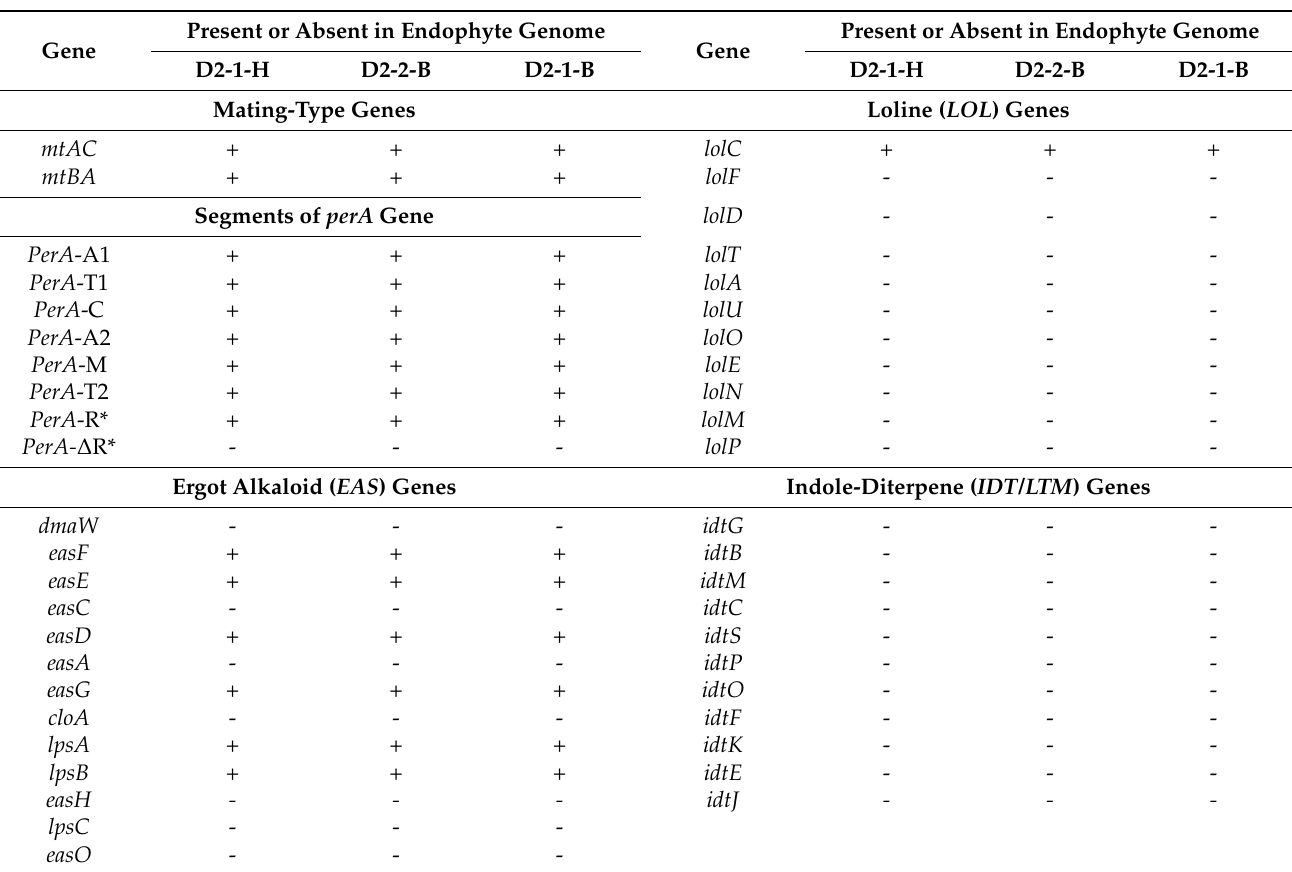
Table 2. Alkaloid gene profiling to determine alkaloid chemotype